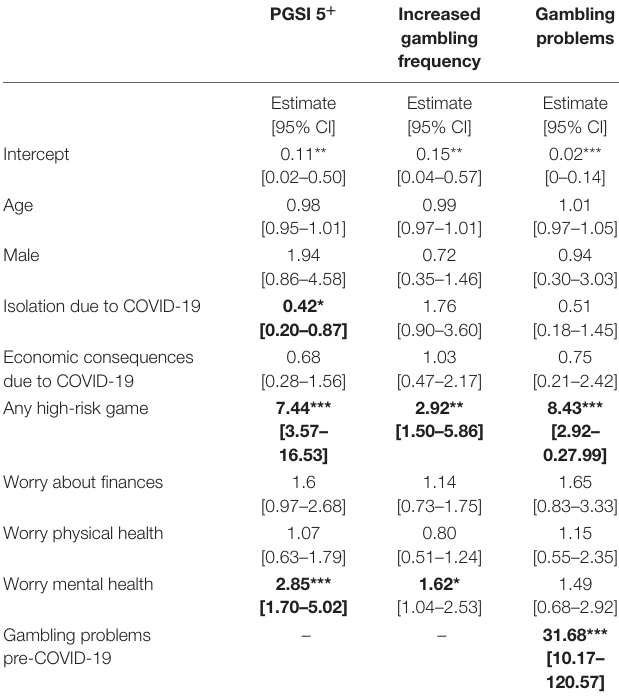
TABLE 3 | Logistic regression model output for first wave.